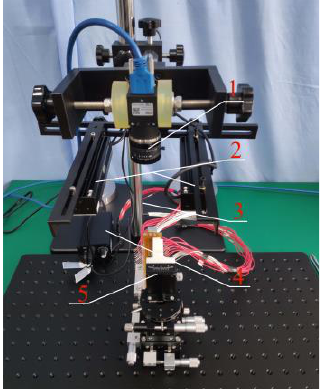
Figure 2. Brush angle measuring device.